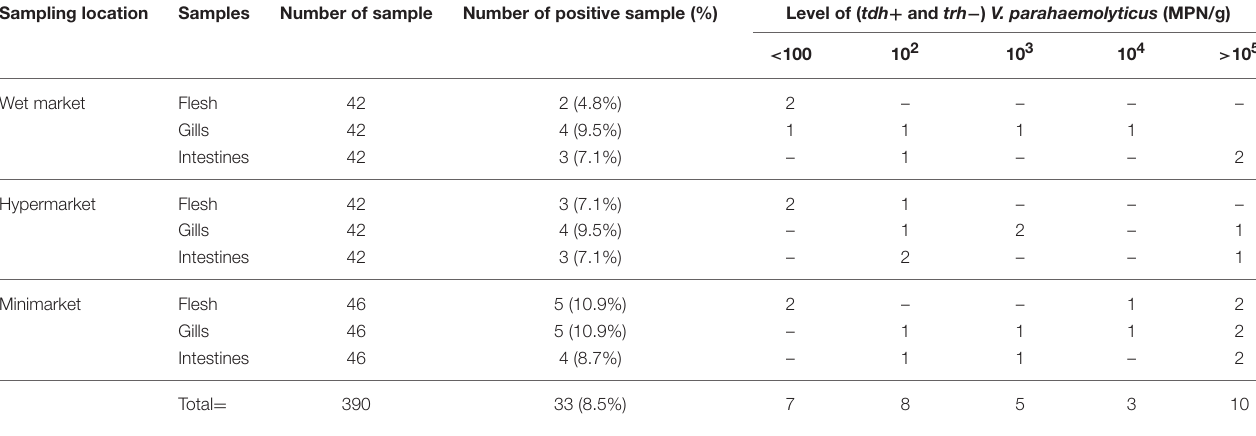
TABLE 2 | Prevalence and microbial loads of pathogenic tdh + and trh − V. parahaemolyticus strains in short mackerels. Sampling